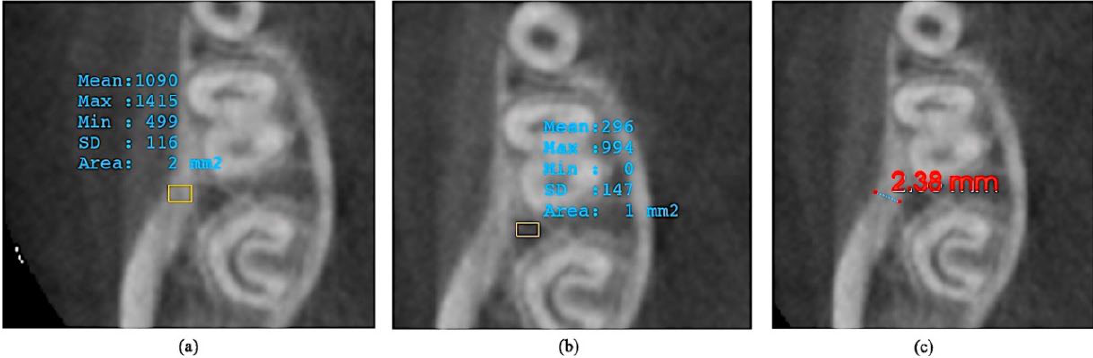
Figure 1. Measurement of cortical and cancellous bone density in the axial view: ( a ) Cortical bone density. ( b ) Cancellous bone density. ( c ) Cortical bone thickness .